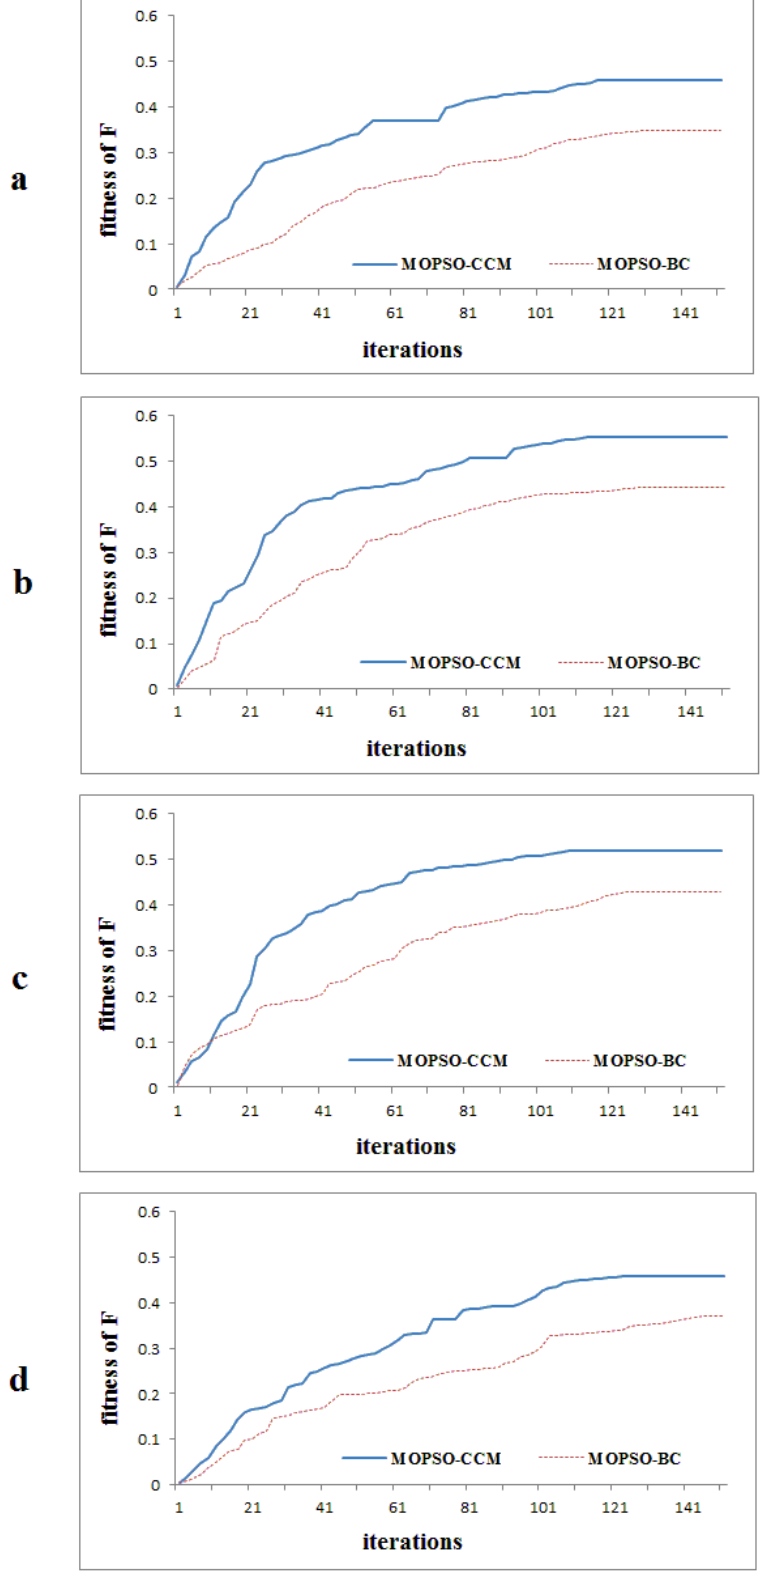
Figure 12. Optimization curves obtained by MOPSO-CCM and the MOPSO-BC model, respectively, with the four weighted scenarios: ( a ): I; ( b ): J; ( c ): K; ( d ):